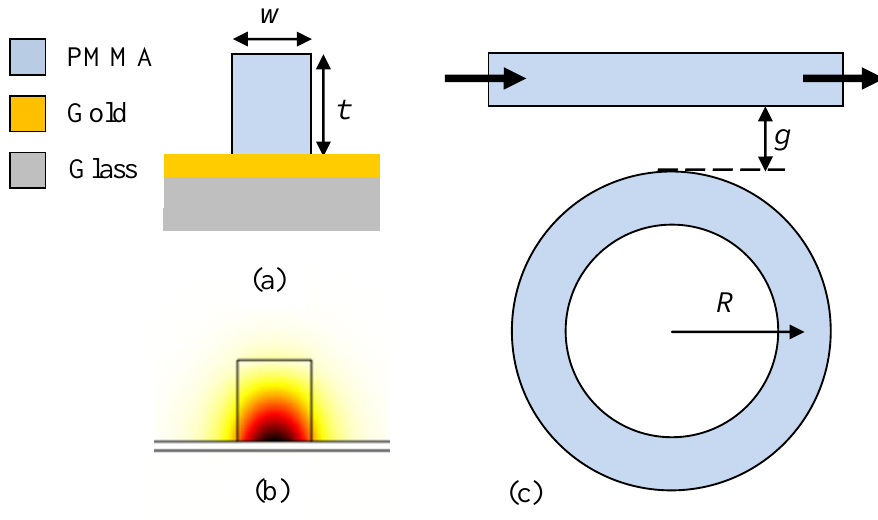
Figure 1. (a) Schematic figure for the cross section of DLSPPW; (b) the mode profile for the DLSPPW at the wavelength of 1.5  m; (c) Schematic illustration of WRR with the dielectric-loaded surface plasmon waveguide laterally coupled to a ring